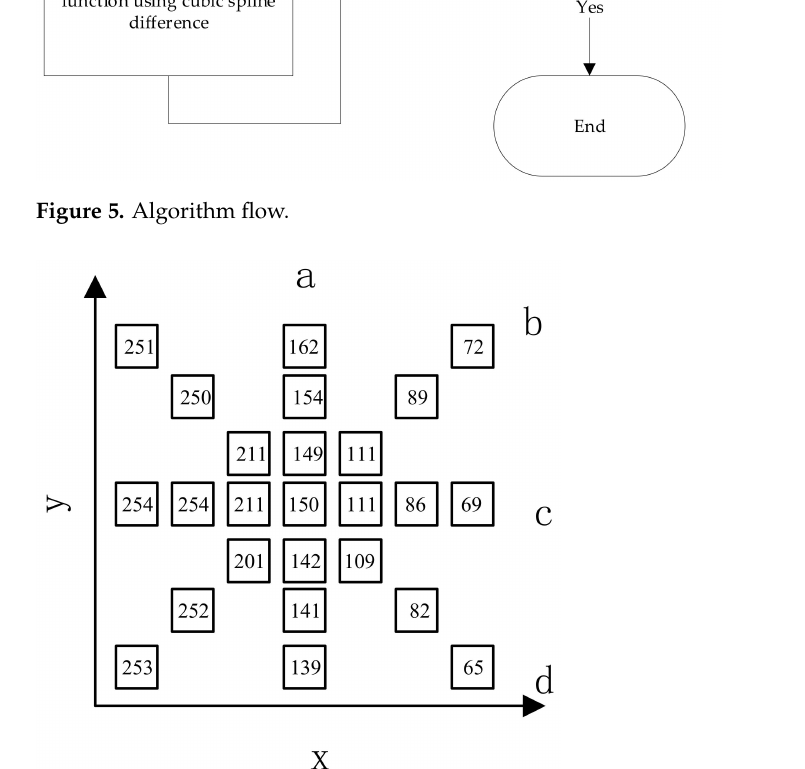
Figure 6. Grayscale values of pixels in each gradient